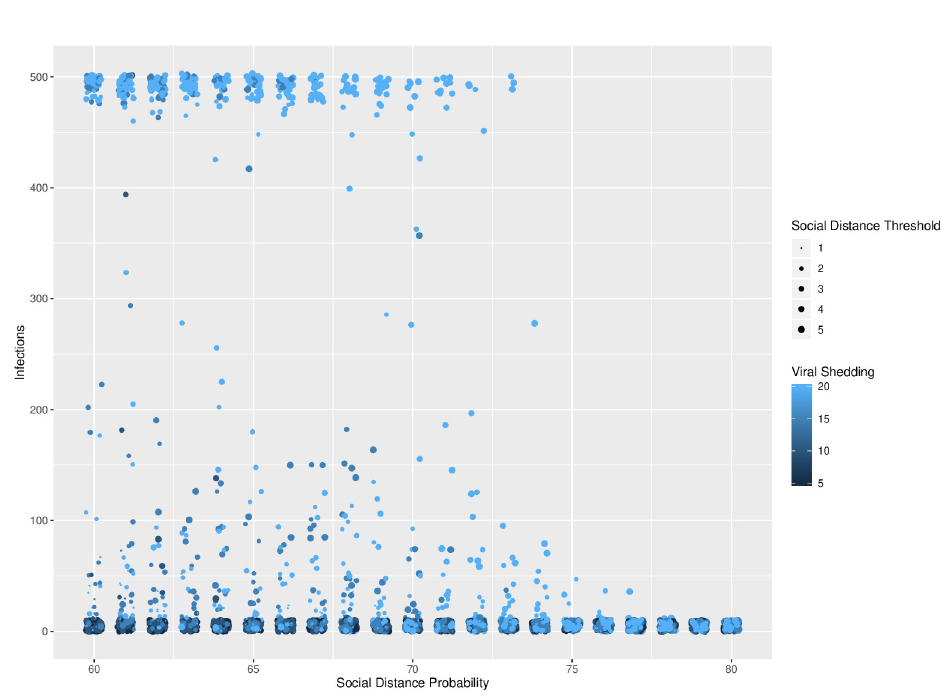
Fig 5. Social distance probability. Social distance probability vs. total number of infected agents for different levels of viral shedding (5% to 20%) and for social distance threshold varying from 1 to 5. A phase transition exists around a social distance probability of 73-74%, across the levels of social distance threshold and viral shedding.